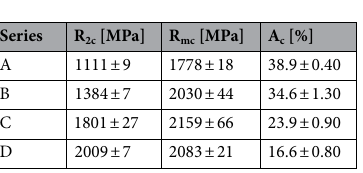
Table 4. Results of the static compression test. Series: A—0%, B—1%, C—5%, D—10% content of the ceramic reinforcement.